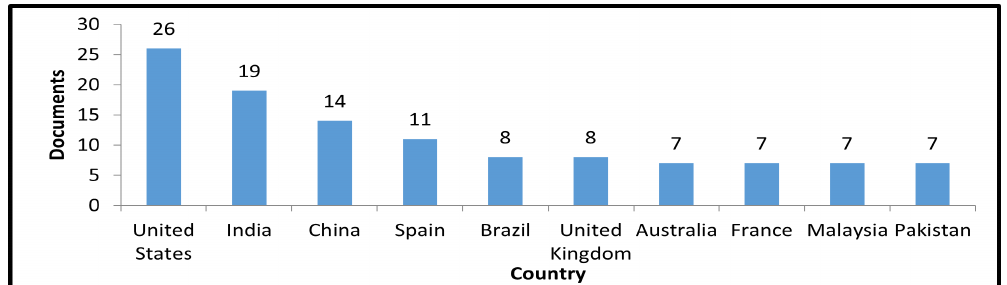
Figure 2. Geographical span of research on plant disease detection using IoT.